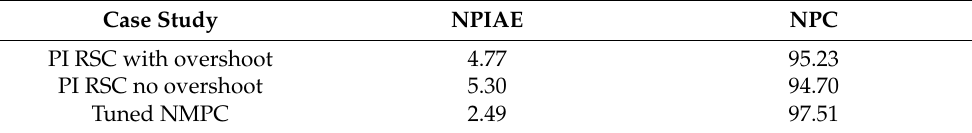
Table 1. Control results. Comparison between proposed approaches (PI RSC and NMPC).